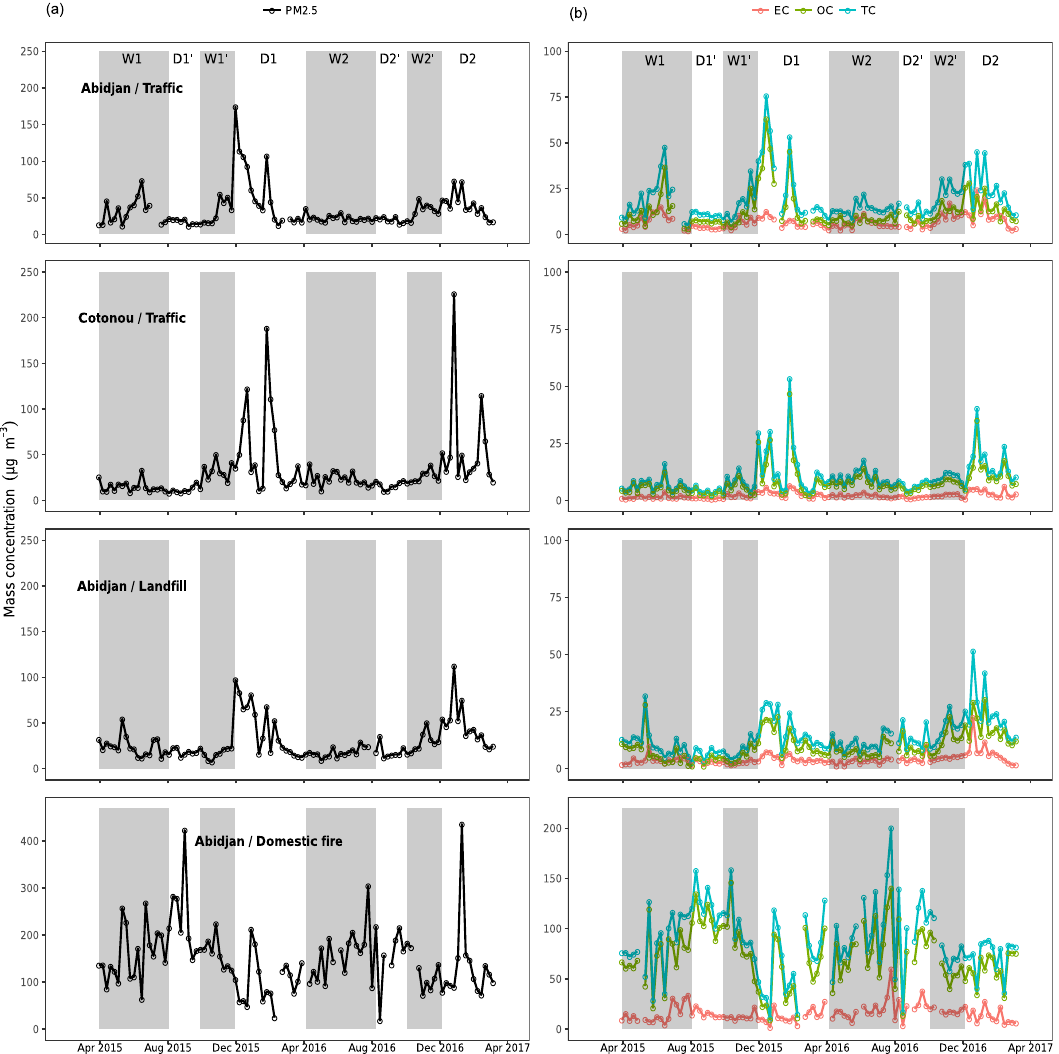
Figure 5. Time series of (a) PM 2 . 5 in µgm − 3 and (b) carbonaceous weekly concentrations in µgCm − 3 at the four sites from April 2015 to March 2017. Shaded areas show the different seasons (see text): the long rainy seasons W1 and W2; the short dry seasons D1 (cid:48) and D2 (cid:48) ; the short rainy seasons W1 (cid:48) and W2 (cid:48) ; and the long dry seasons D1 and